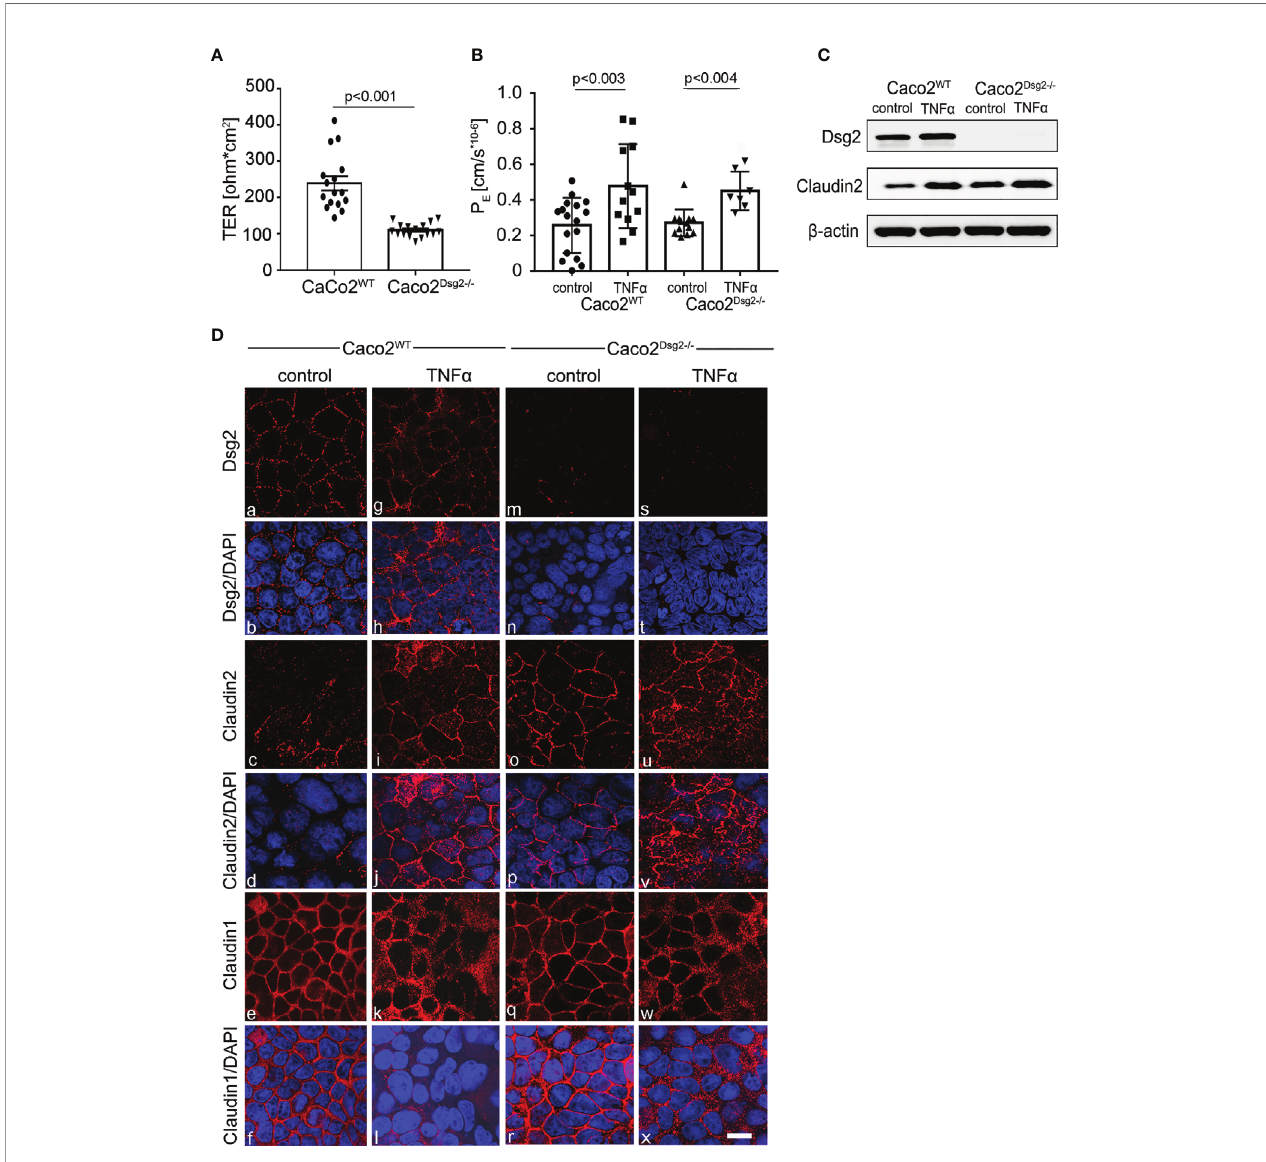
FIGURE 5 | Claudin2 was increased following Dsg2 knockout in Caco2 cells. (A) Measurements of Transepithelial Electrical Resistance (TER) of CaCo2 WT compared to CaCo2 Dsg2 -/- monolayers under baseline conditions demonstrate reduced baseline TER in Dsg2-de fi cient cells (p<0.001, n=13, ordinary 1-way ANOVA). (B) Permeability coef fi cient (P E ) of 4kDa FITC Dextran on Caco2 WT cells (p<0.003 compared to control, n=12, ordinary 1-way ANOVA) and in Caco2 Dsg2 -/- cells (p<0.004 compared to Caco2 Dsg2 -/- control, n=12, ordinary 1-way ANOVA) show increased permeability after incubation with TNF a whereas no differences under baseline conditions are obvious (n=12, ordinary 1way ANOVA). (C) Western Blot experiments of CaCo2 WT and CaCo2 Dsg2 -/- monolayers is shown for Dsg2, Claudin2 and for ß-actin to verify equal loading of the Western Blots. This con fi rms loss of Dsg2 in CaCo2 Dsg2 -/- cells and augmented basal expression of Claudin2 compared to CaCo2 WT ; the experiment shown is representative for n=8. (D) Immunostaining of Caco2 WT and Caco2 Dsg2 -/- for Dsg2 (a, g, m, s), Claudin2 (c, i, o, u) and Claudin1 (e, k, q, w) are shown under baseline (control) conditions (a-f, m-r) and following application of TNF a (g-l, s-x) for 24h. Dsg2 is found at the cells borders in Caco2 WT under control conditions (a). TNF a leads to a loss of Dsg2 at the cell borders (g) and in Caco2 Dsg2 -/- no Dsg2 was detectable (m, s). Claudin2 is hardly detectable in Caco WT under control conditions (c) but can be found at the cell membrane after TNF a incubation (i). In Caco2 Dsg2 -/- cells Claudin2 staining pattern shows a distribution at the cell borders in both control and after TNF a treatment (o, u). Claudin1 is found at the membrane in both Caco2WT and Caco2Dsg2-/- cells under control conditions (e, q), which is reduced following application of TNF a (k, w) (n=4; scale bar is 20